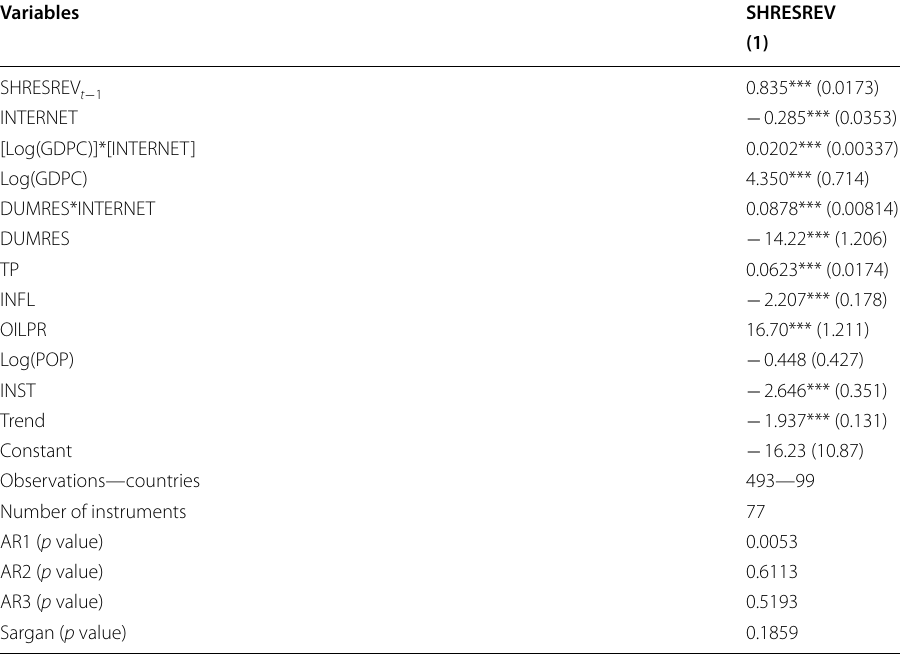
Table 5 Does the impact of the Internet usage intensity on the share (%) of resource revenue in total resource revenue depend on countries’ level of